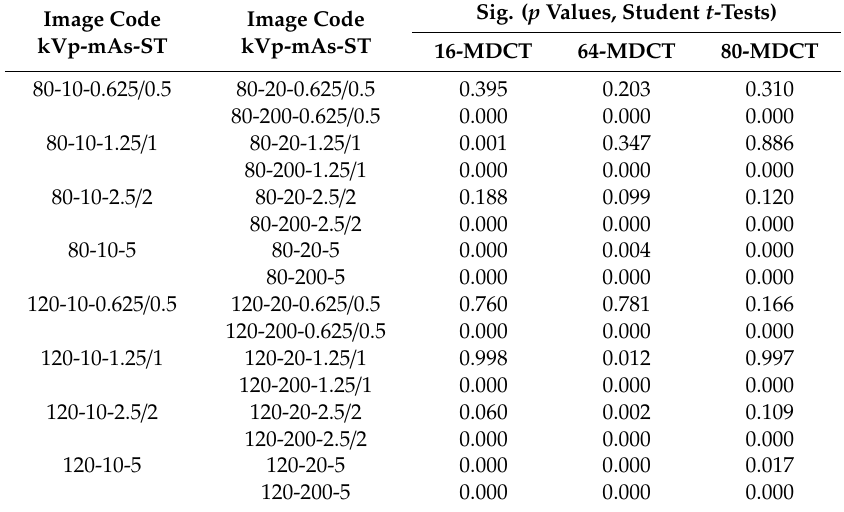
Table 7. Dissimilarities ( p values, student t -tests) between images utilising the same kVp and mAs with mAs variations in each CT scanner.